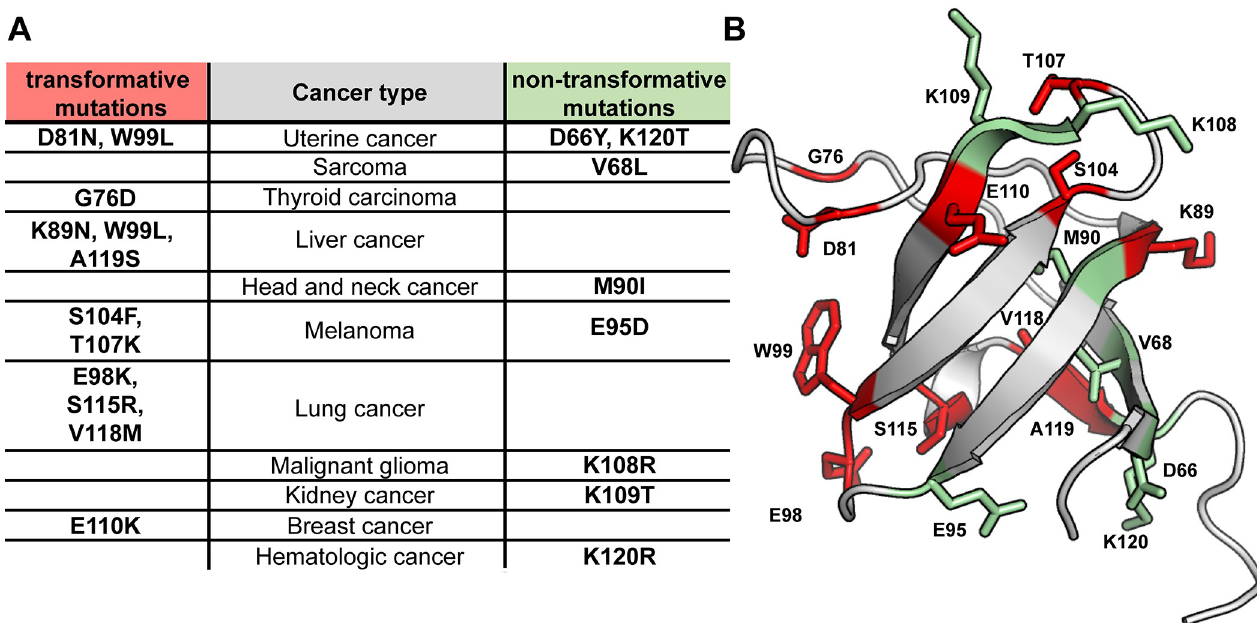
Fig 3. Cancer-associated mutations of the Lyn SH3 domain. A. Mutations of 18 out of the 61 amino acids of the Lyn SH3 domain were identified by genome sequencing of patients with the indicated types of cancer [23–25]. The table separates these mutations into likely-transformative and likely non-transformative, based upon prior computational analysis [58]. B. Locations of the likely transformative cancer-associated mutations are shown in red . Locations of the likely non-transformative substitutions are shown in green .